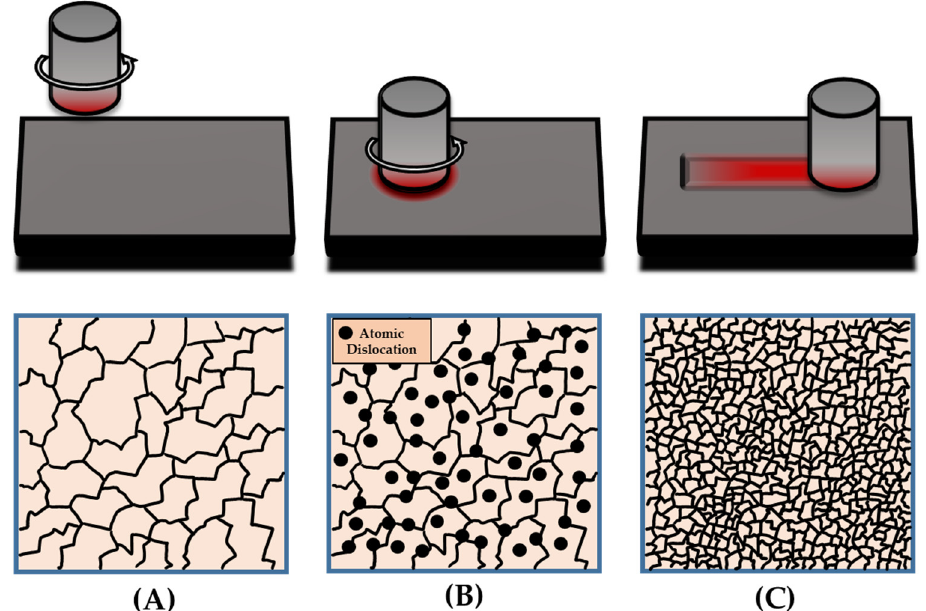
Figure 3. A schematic of the dynamic recrystallization process consisting of the ( A ) material in its base form, ( B ) the initial plunge into the working material, thus inducing severe atomic dislocations (shown by circles), ( C ) the reorientation of the atomic structure and the finalized grain structure.